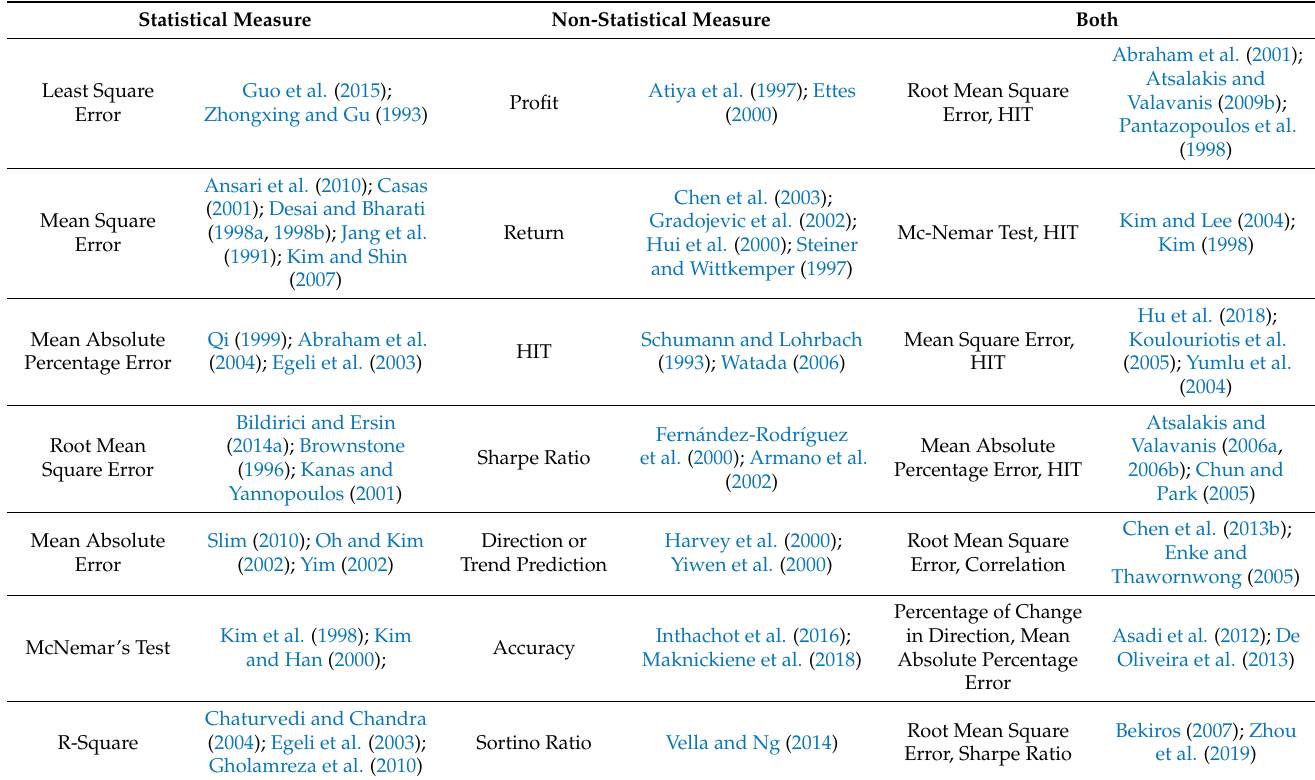
Table 6. Performance